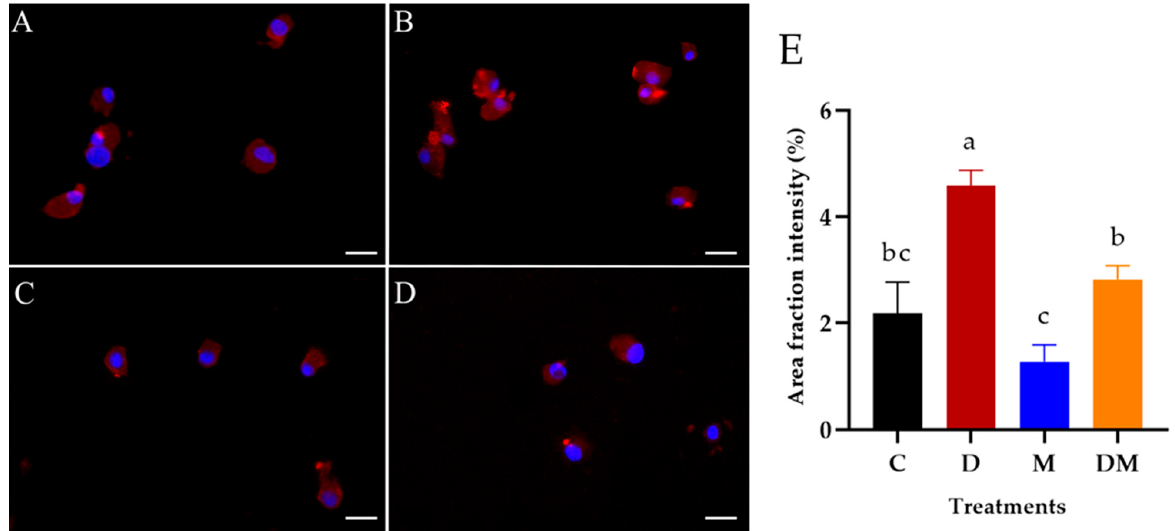
Figure 3. Detection of dopamine in the hemocytes of Rhipicephalus microplus tick females 24 h after injection of dopamine and Metarhizium anisopliae . ( A ) Untreated ticks (Control); ( B ) Ticks injected exclusively with dopamine; ( C ) Ticks inoculated exclusively with M. anisopliae blastospores; ( D ) Ticks injected with dopamine and M. anisopliae blastospores. Dopamine was visualized by fluorescence microscope (BX 51; Olympus, Tokyo, Japan) in the hemocytes (Alexa Fluor 594; red). Nuclei were counterstained with DAPI (blue). Scale bars = 10 μ m. ( E ) Average fluorescence intensity (marked area) percentage and standard error of dopamine in R. microplus hemocytes calculated using the ImageJ software (National Institute of Health, Bethesda, MD, USA). Bars with the same letter do not differ statistically according to the one-way ANOVA followed by the Tukey’s test ( p > 0.05).